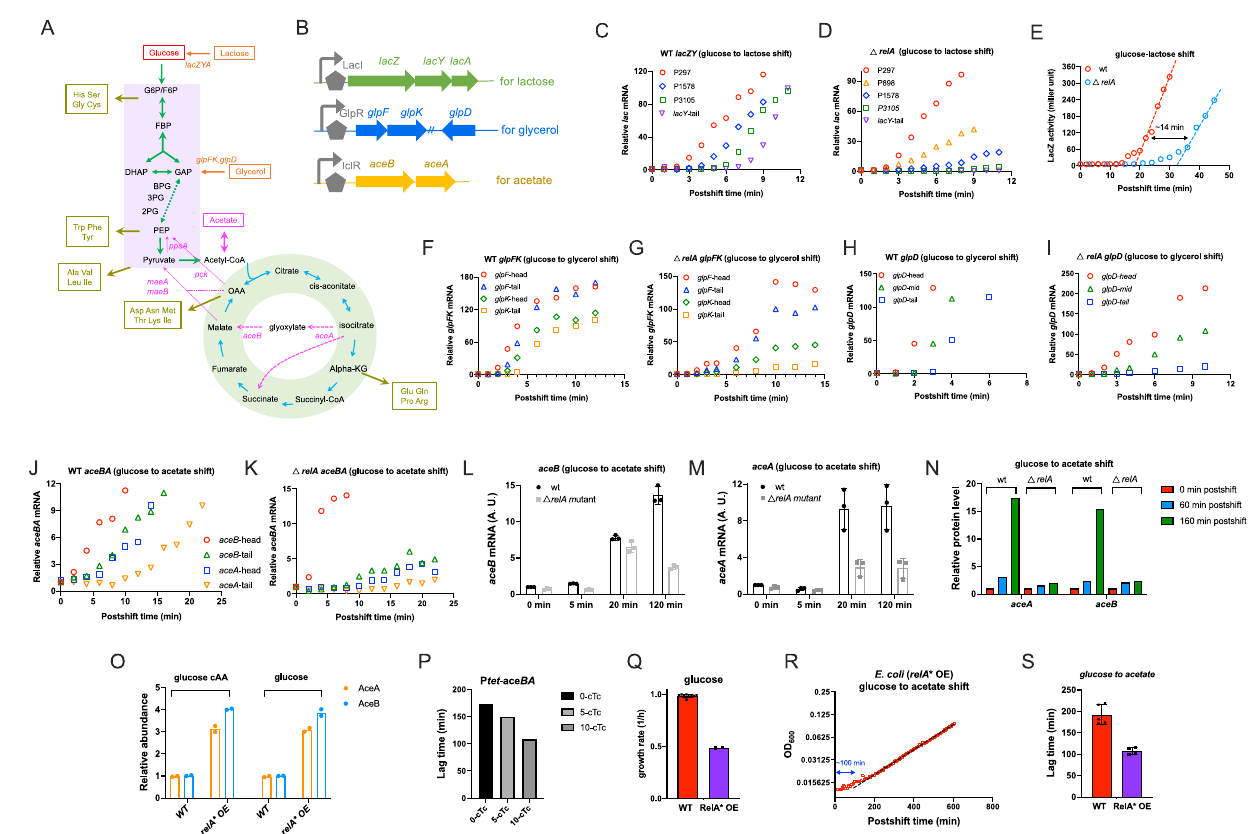
Fig. 6 | The induction kinetics of catabolic operons in E. coli during carbon downshift. A The central catabolic pathways of E. coli for related carbon sources. B Three catabolic operons. C , D The induction kinetics of lac mRNA in E. coli wild type strain and relA -de fi cient strain during glucose to lactose transition. E The inductionkineticsofLacZ proteinin E.coli wildtypestrainand relA -de fi cientstrain duringglucosetolactosetransition. F , G Theinductionkineticsof glpFK mRNAin E. coli wild type strain and relA -de fi cient strain during glucose to glycerol transition. H , I Theinductionkineticsof glpD mRNAin E.coli wildtypestrainand relA -de fi cient strain during glucose to glycerol transition. J , K The induction kinetics of aceBA mRNA in E. coli wild type strain and relA -de fi cient strain during glucose to acetate transition. L , M The relative abundances (LFQ intensity) of aceB and aceA mRNA (detected by their 3 ’ -tail region primers) of E. coli at different time points after shifting from glucose to acetate medium. Error bars are the standarddeviations of